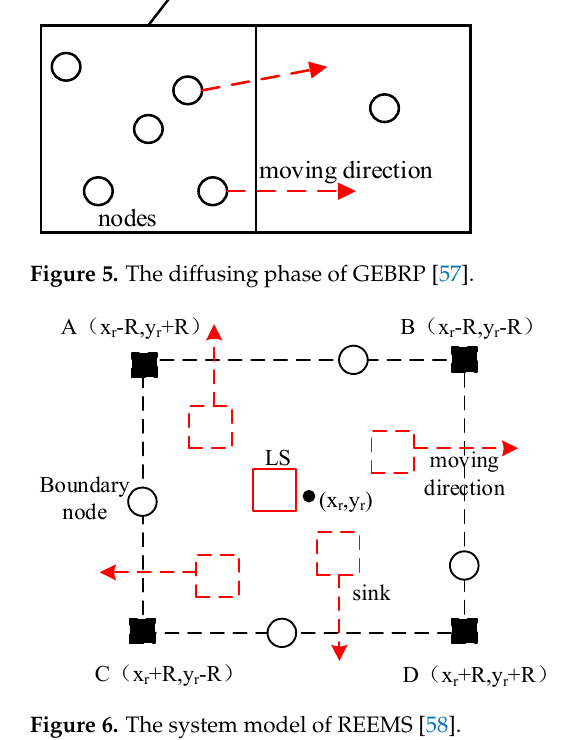
Figure 6. The system model of REEMS [58].